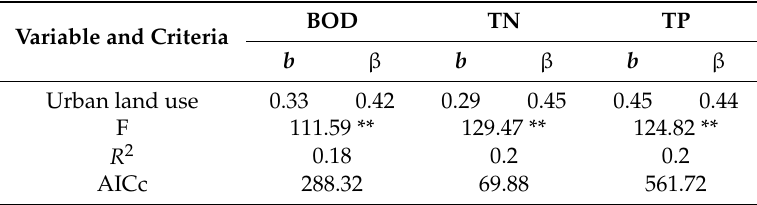
Table 3. Outputs from linear models of the relationships between the proportion of urban land use and water quality indicators. All water quality variables were strongly influenced by the proportion of urban land